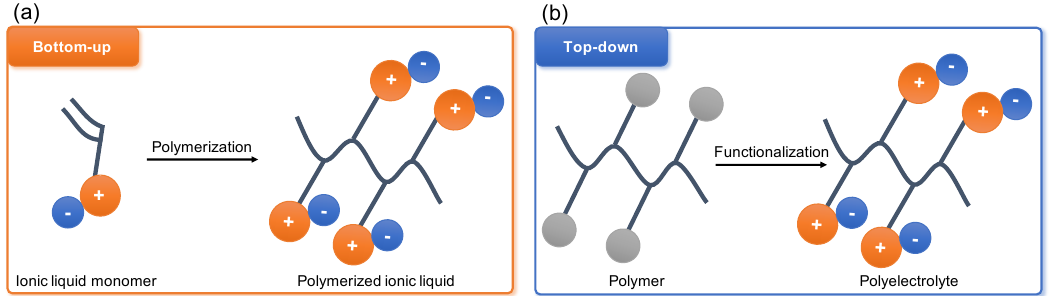
Figure 2. Crucial difference between polymerised ionic liquids (PILs) ( a ) and post-synthetic or ‘top-down’ modification of polyelectrolytes ( b ) stems from chemical origin of polymer chain bearing the ionic charges. In PILs it forms by polymerisation of ionic monomers, and in ‘top-down’ polyelectrolytes it is already present in parent